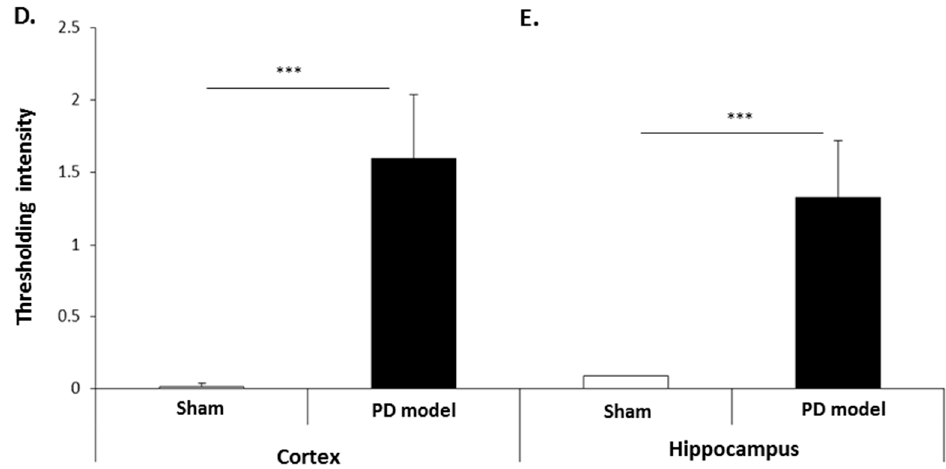
Figure 8. Total deiminated proteins are increased in brain tissue of pre-motor PD rats. Total deiminated protein expression was assessed by immunohistochemistry using the pan-deimination F95 antibody. ( A ) Increased protein deimination is observed in the brain vasculature in the cortex (ctx) of the pre-motor PD rat brains compared with that in the sham control brains. ( B ) Increased protein deimination is observed in white matter (wm) of the pre-motor PD rat brains compared with sham brains. ( C ) Increased protein deimination (F95 positive) is observed in the hippocampus (hip) of the pre-motor PD rat brains, compared with sham brains; the scale bars indicate 100 µm in all figures (ctx=cortex, hip=hippocampus, wm=white matter). ( D , E ) Thresholding intensity analysis of F95 positive staining showed a significant increase in the cortex ( D ), and the CA1 region of the hippocampus ( E ) of pre-motor PD models, compared with that in control sham brains (unpaired t-test, *** p < 0.001).